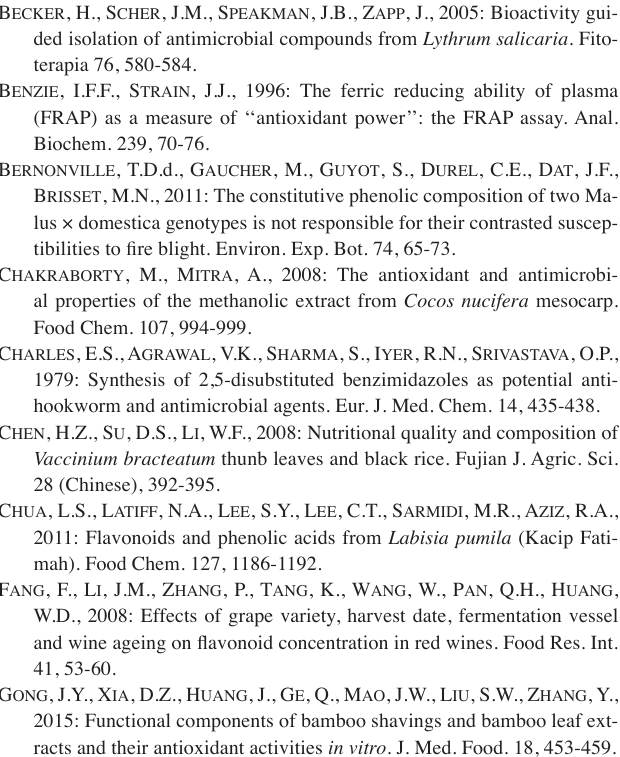
Tab. 4: Antimicrobial activities of the VBE